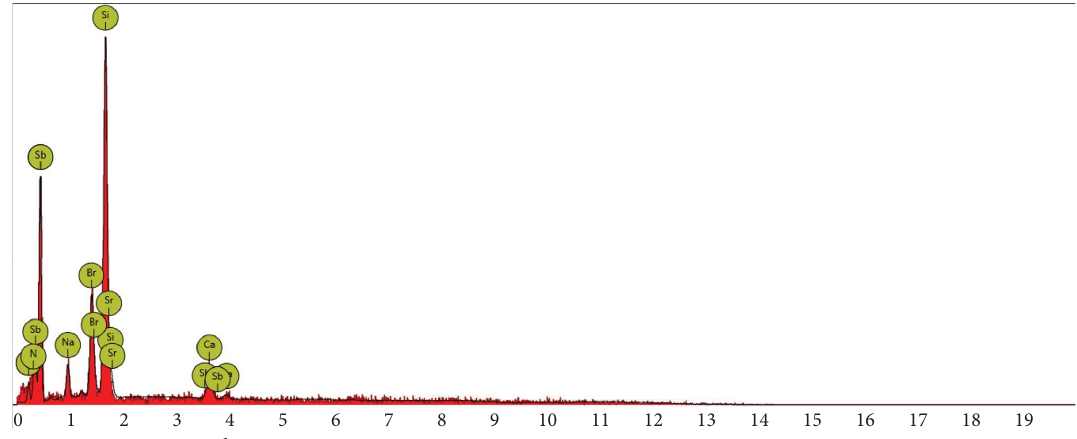
Figure 34: Graphical representation of elements concentration for M3 sample at room